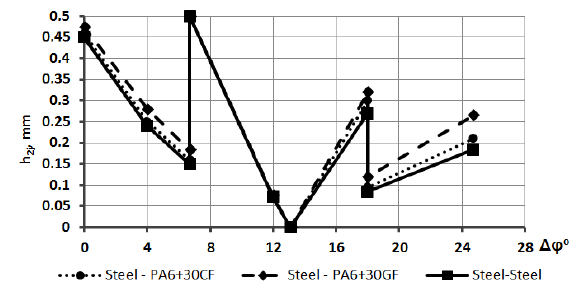
Figure 6. Wear of the tooth profile during the engagement. The change in sliding speed during engagement is shown in Fig.7 At the entrance of the teeth into the engagement and at the exit from it, the sliding speed will have the opposite direction and approximately the same value for all types of gear trains.